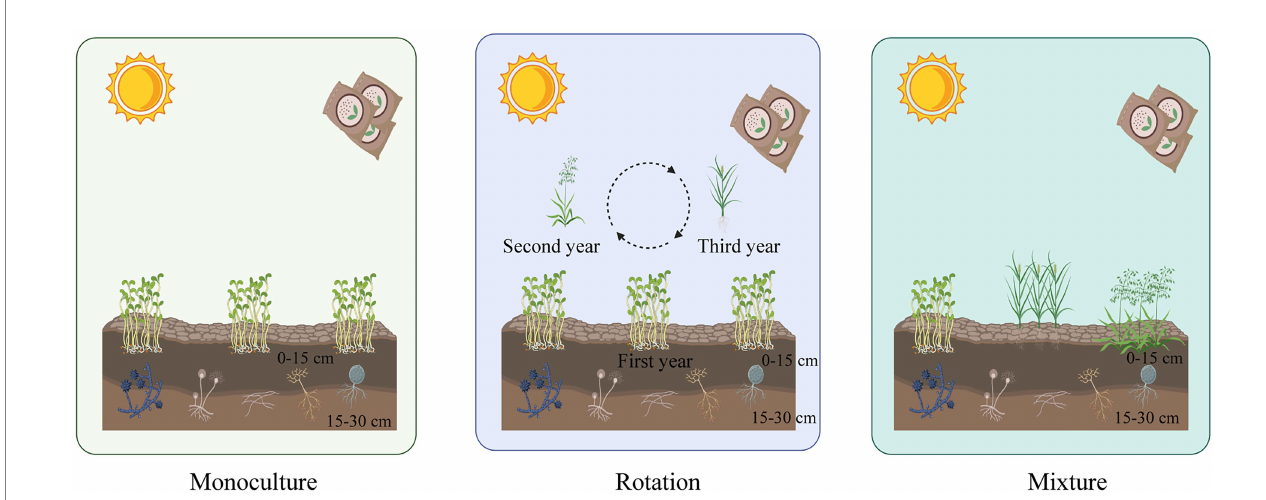
FIGURE 1 A diagrammatic sketch to show our experimental design. Three cropping patterns, monoculture, rotation, and mixture systems were cropped in each of the three plots. Alfalfa is cropped in monoculture soils yearly. A rotation of alfalfa–oat–tall wheatgrass that has been managed in this way for 13 years, with annual alfalfa in the first year, followed by oats in the second year and tall wheatgrass in the third year, in a three-year rotation. A mixture system plot where alfalfa, oats, and tall wheatgrass were grown